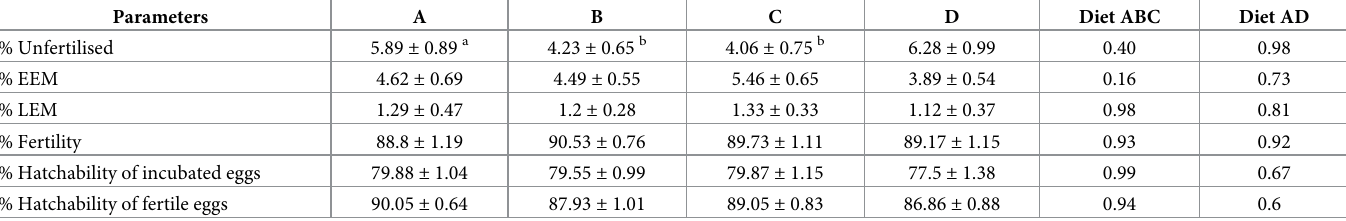
Table 2. Percentage of unfertilised eggs, early (EEM) and late (LEM) embryonic mortality and fertility after artificial insemination in broiler hens fed with GSE supplementation.